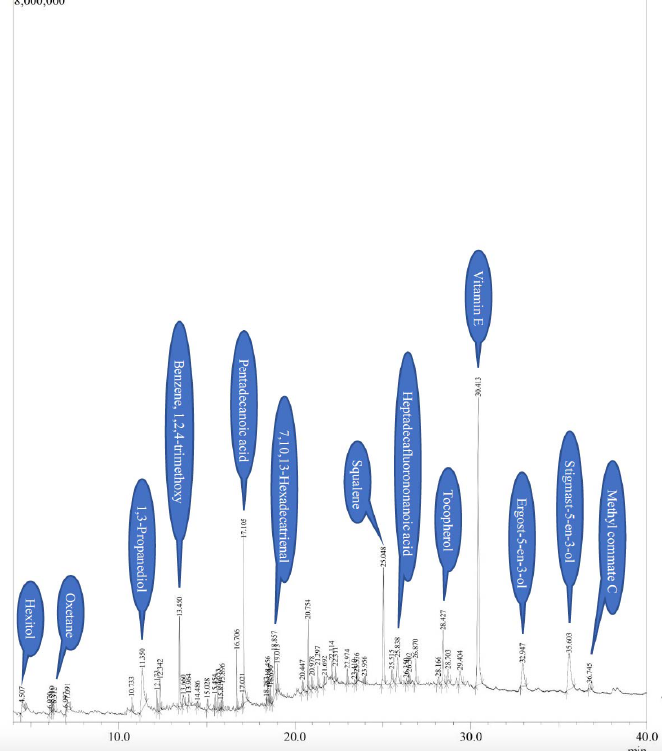
Figure 5. Phytoconstituents detected in the methanol leaf extract of the mother plant of D. palmatus using